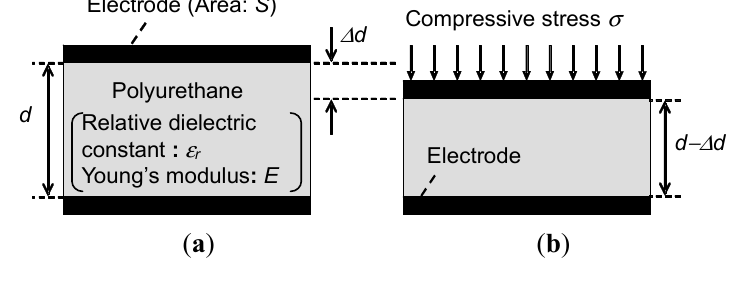
Figure 2. Schematic cross-section of established tactile sensor using poly-urethane without gap ( a ) at initial state; and ( b ) after compression.